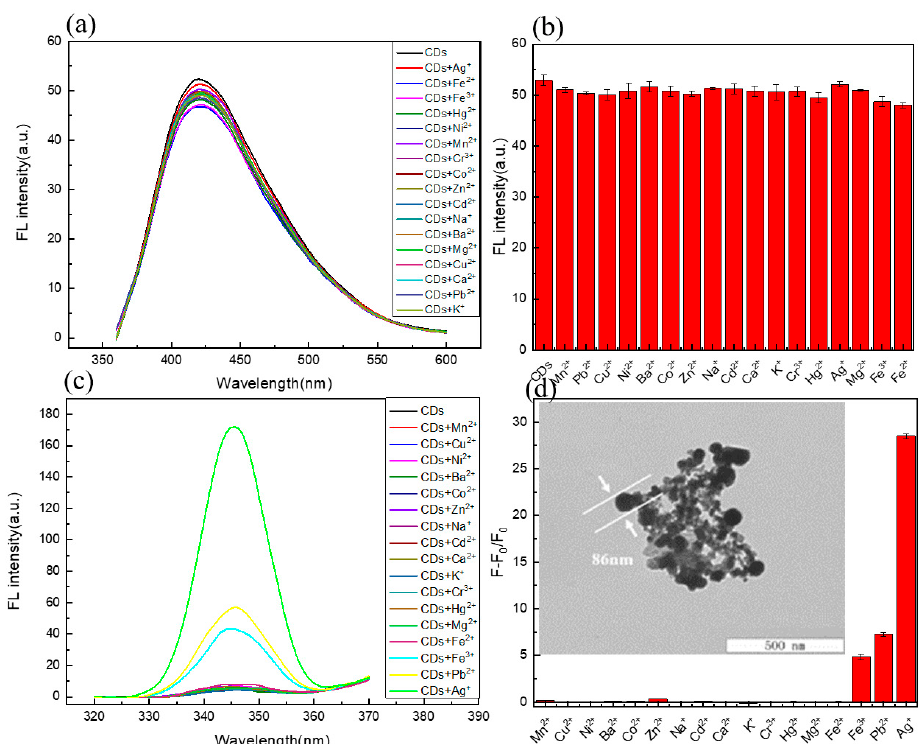
Figure 3. ( a ) Response of FL intensity in C/N-dots aqueous with the addition of different metal ions; ( b ) Effects of metal ions on the FL intensity of C/N-dots; ( c ) Response of RLS intensity with the addition of different metals ions; ( d ) Effects of metal ions on the RLS intensity of C/N-dots. F and F 0 correspond to the FL intensities of the C/N-dots–Ag + complex system with and without metal ions (33.3 µ M), respectively.